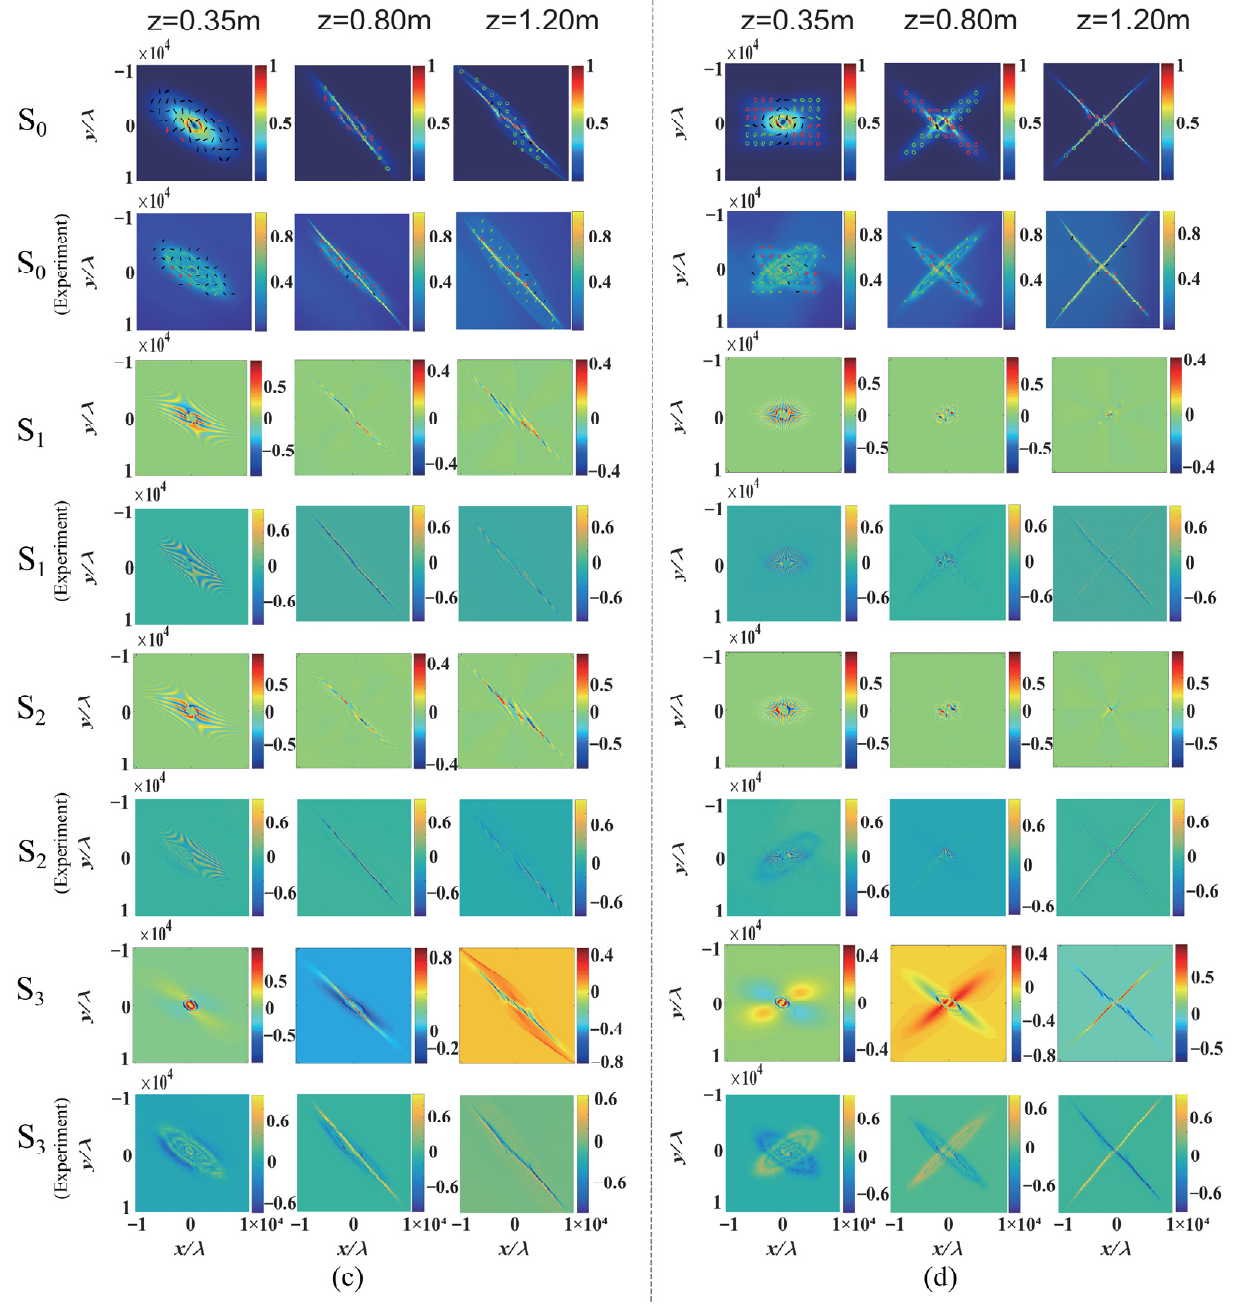
Figure 3. Stokes parameters of isotropic ( σ x = σ y =5 mm in ( a , b )) and anisotropic ( σ x = 2 σ y =4 mm in ( c , d )) twisted vector beams local linearly polarized in different propagation distances: ( a ) u 1 = 10 mm − 2 , u 2 = 15 mm − 2 , m 1 = 4, m 2 = − 1; ( b ) u 1 = 10 mm − 2 , u 2 = − 10 mm − 2 , m 1 = 4, m 2 = − 1; ( c ) u 1 = 10 mm − 2 , u 2 = 15 mm − 2 , m 1 = 4, m 2 = − 1; ( d ) u 1 = 10 mm − 2 , u 2 = − 10 mm − 2 , m 1 = 4, m 2 = − 1. The corresponding experi- mental results of S 0 are shown in the second − row plots of each case.